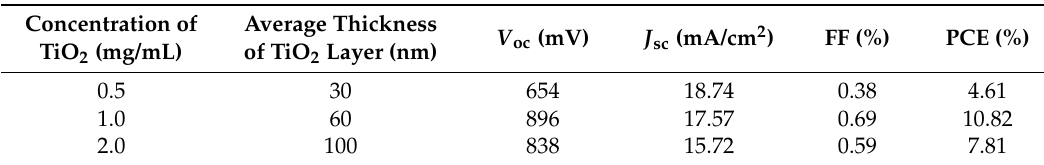
Table 1. The performance of devices fabricated based on the w-film ultrasonically sprayed TiO 2 with different thicknesses tuned by the concentration of TiO 2 dispersion.